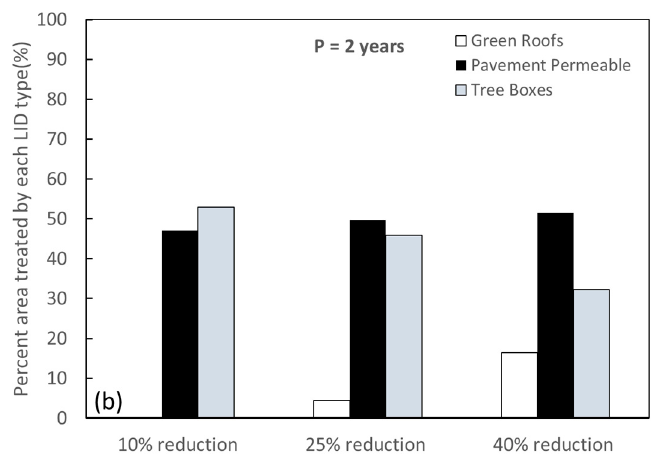
Figure 4. Percentage of each LID configuration for the three optimal TSS load reduction solutions: 10%, 25%, and 40%: ( a ) percentage of the number of each LID; ( b ) percentage of the area treated by each LID.